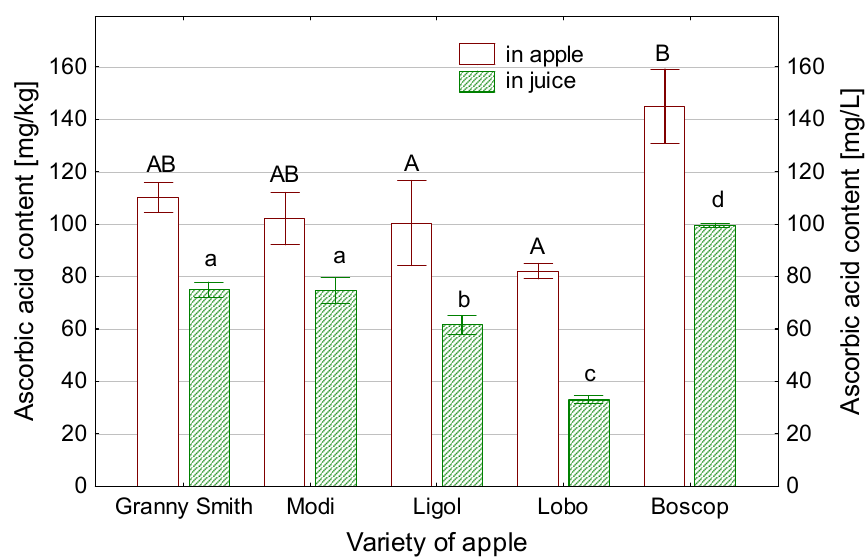
Figure 7. The effects of various varieties on content of ascorbic acid in the fresh apples and apple juice. Different capital letters indicate values significantly different at p < 0.05 in apples. Different lowercase letters indicate values significantly different at p < 0.05 in juices.